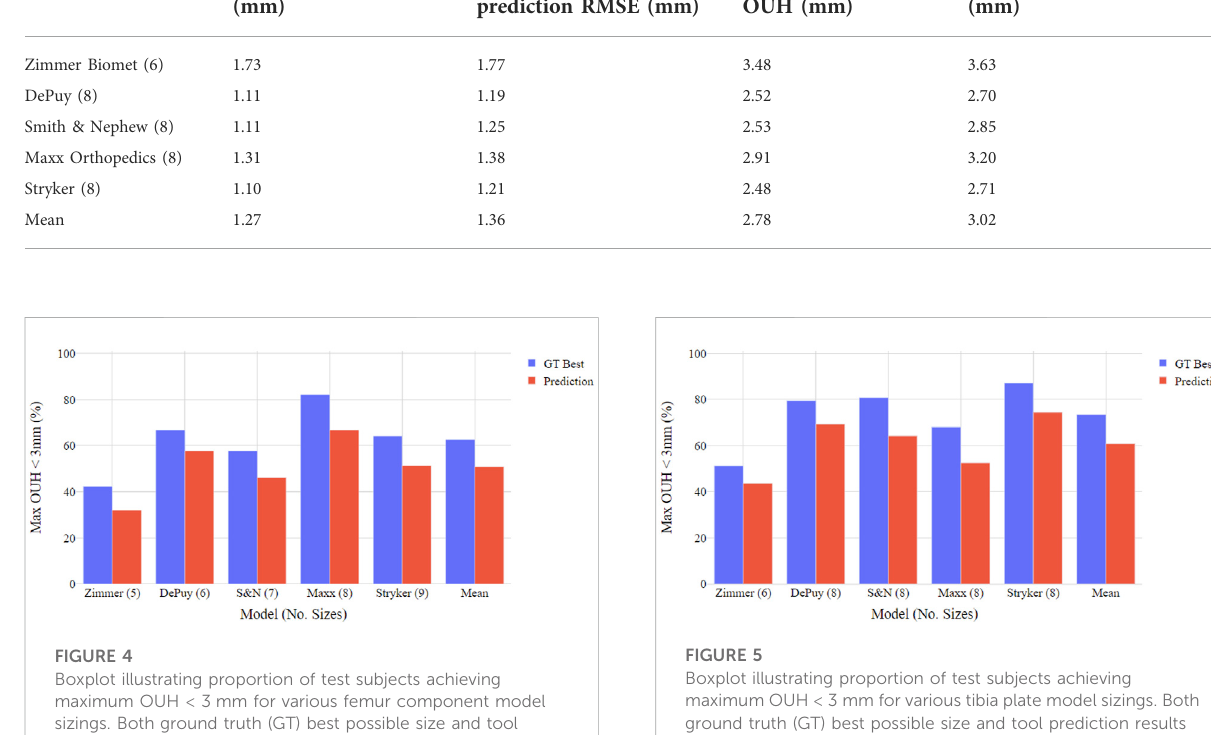
TABLE 7 Tibia plate mean RMSE and mean maximum OUH results for ground truth (GT) best sizes and predictions, split by manufacturer model sizings. Model (no. Sizes)